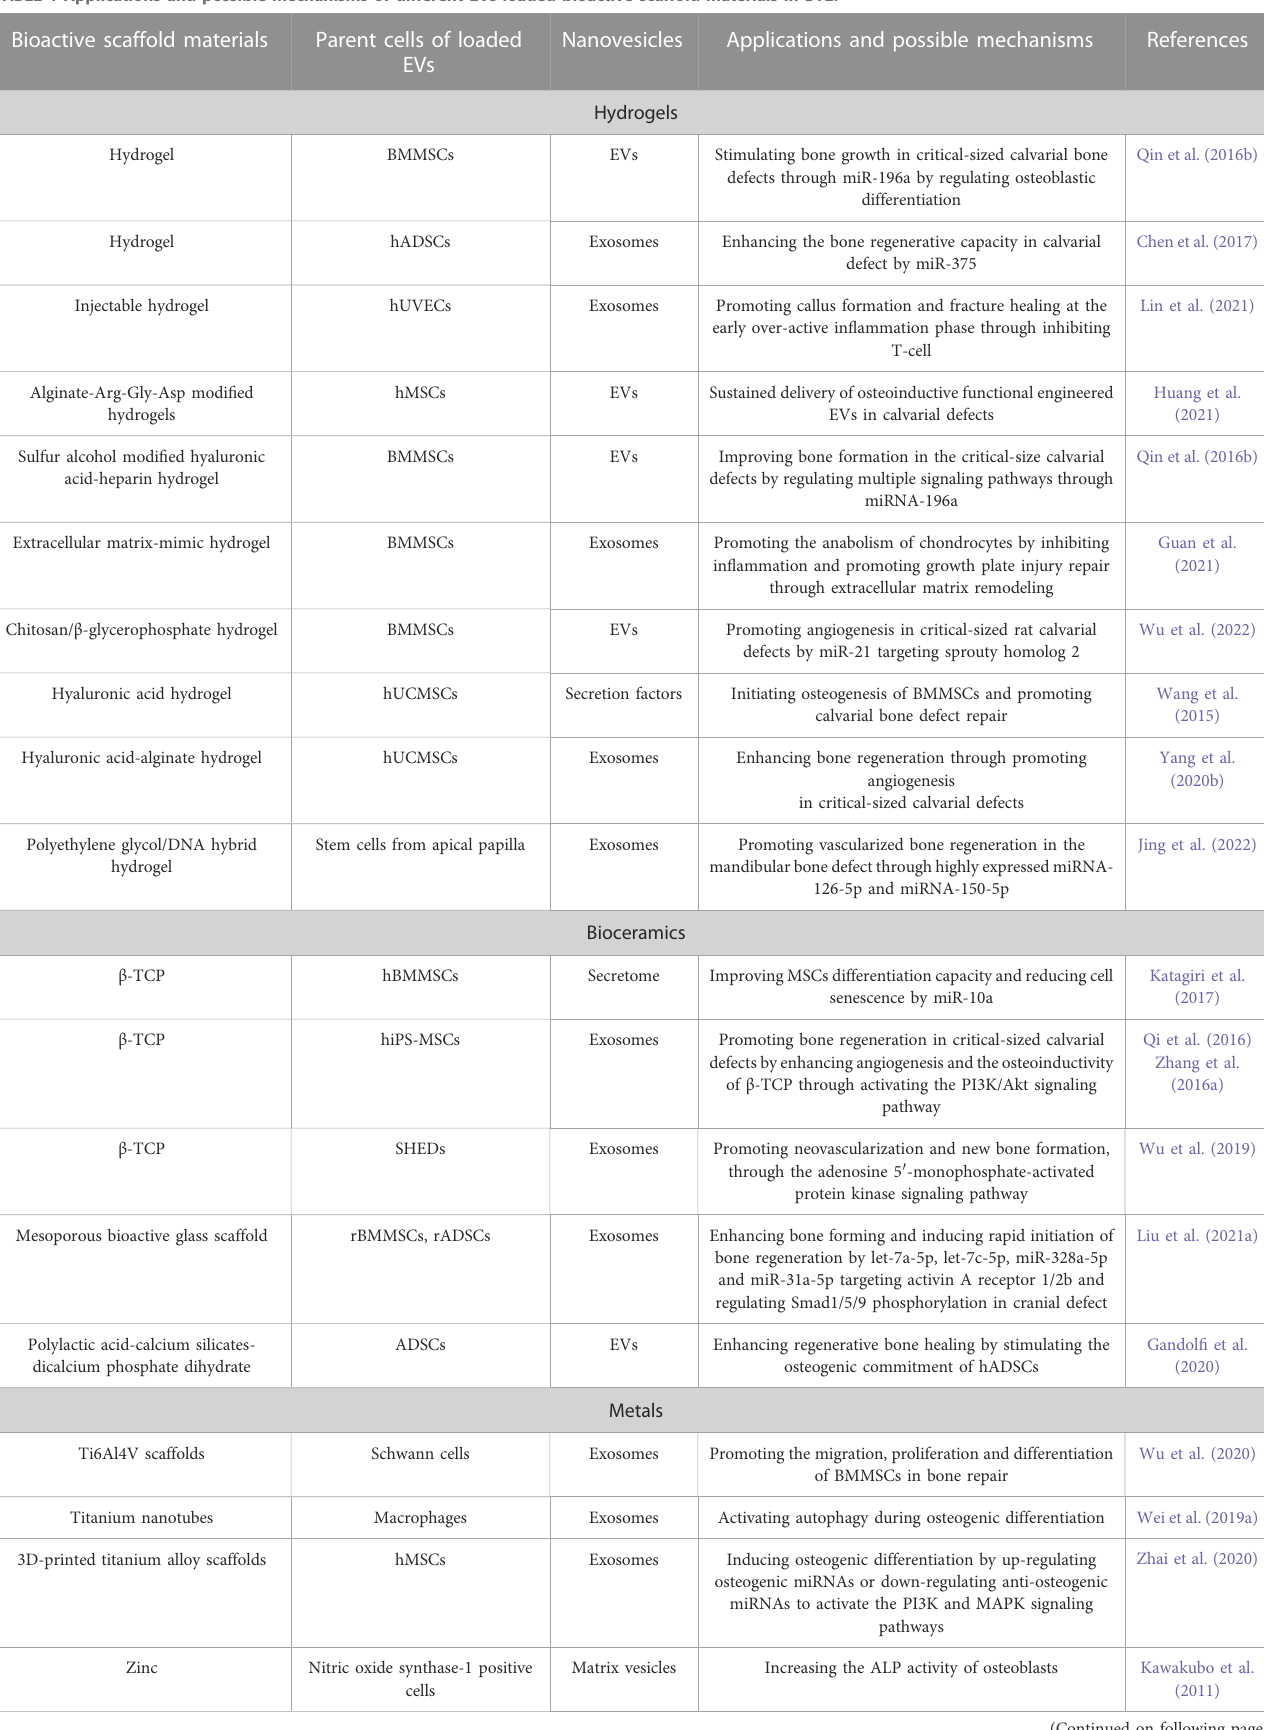
TABLE 1 Applications and possible mechanisms of different EVs-loaded bioactive scaffold materials in